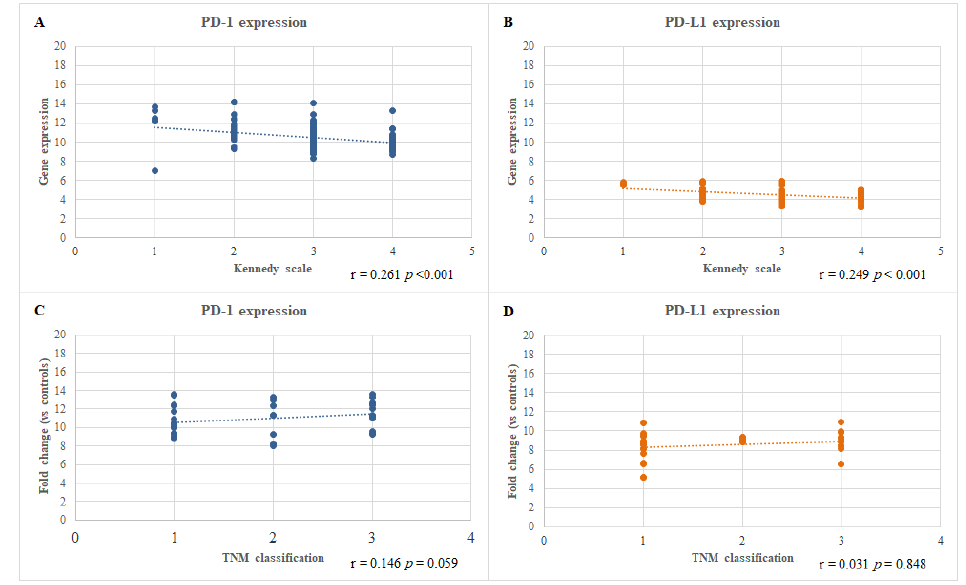
Figure 3. Correlation between the mRNA expression levels of the PD-1 ( A , C ) and PD-L1 ( B , D ) genes and the extent of the diseases calculated using the Kennedy score for the CRSwNP patients ( A , B ) and TNM staging system for the HNC patients ( C , D ).